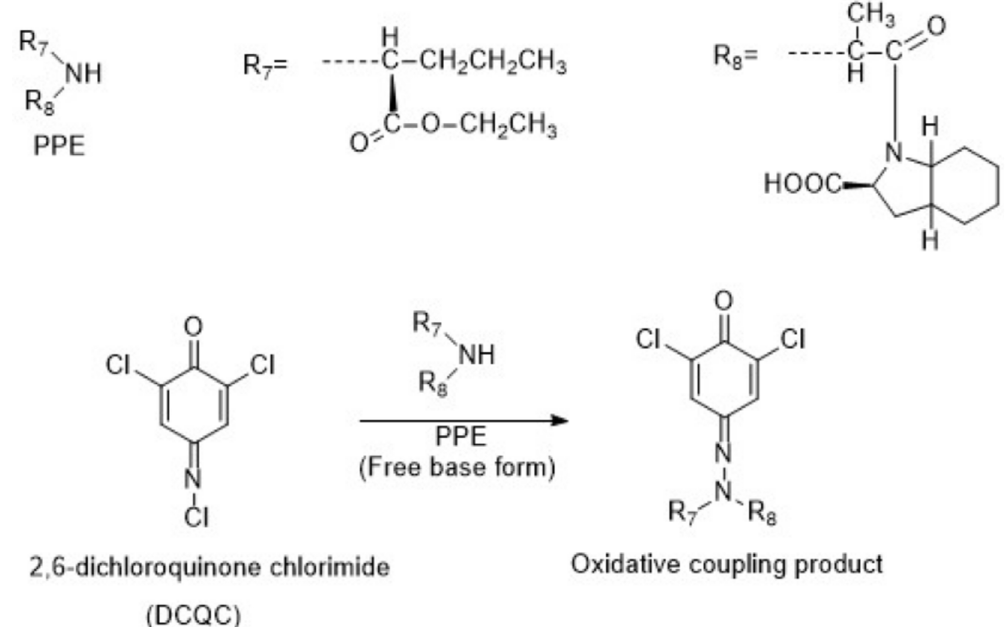
SCHEME 1 - Formation of oxidative coupling product between drug (PPE) and DCQC